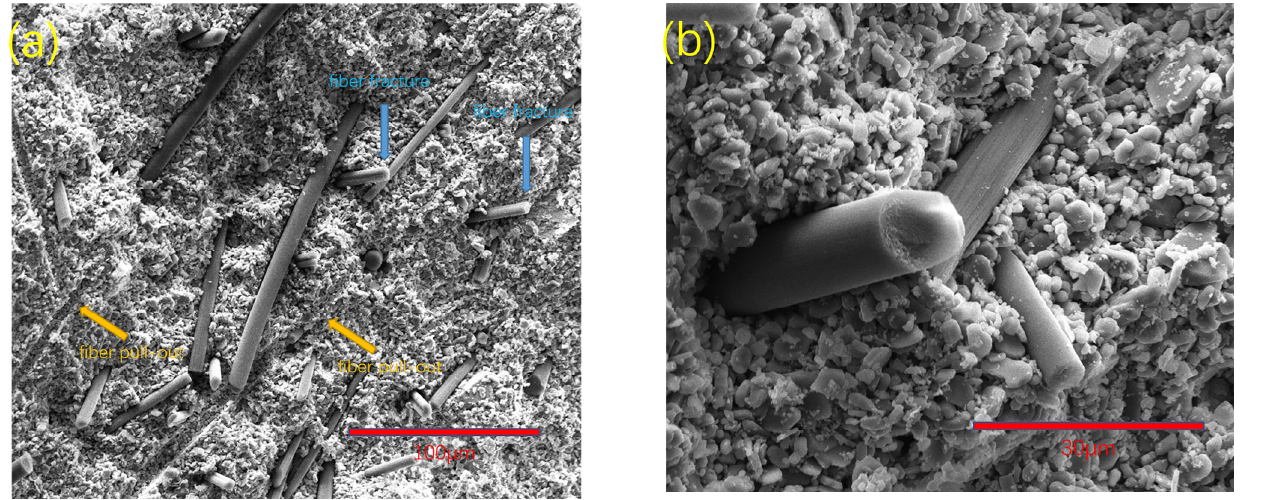
Figure 6. The 3D-printed SEM images of fracture of group A samples of alumina composite ceram- ics: ( a ) with 500× magnification and a scale of 100 μ m, fiber pullout and fiber fracture were ob- ( a ) with 500 × magnification and a scale of 100 µ m, fiber pullout and fiber fracture were observed; served; ( b ) with 2000× magnification and a scale of 30 μ m, a clear image of fiber fracture can be seen. ( b ) with 2000 × magnification and a scale of 30 µ m, a clear image of fiber fracture can be